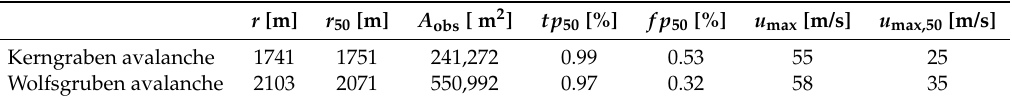
Table 1. Avalanche observation data y obs (runout r , observed affected area A obs , maximum velocity u max ) and median (50% quantiles) values of the corresponding simulation